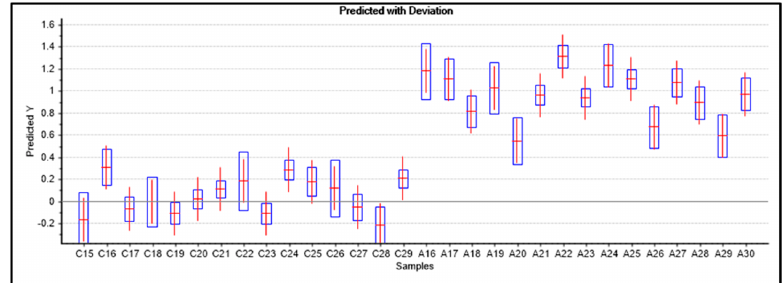
Figure 8. PLSModel predicted Y values for ASD (A group) and control (C group) test samples. The predicted values are indicated by the horizontal red lines, and the deviations by the blue boxes. In the